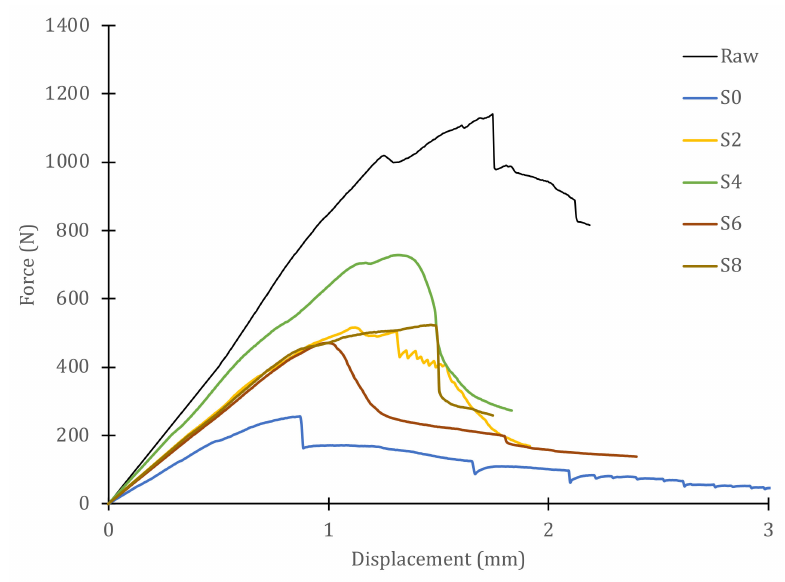
Figure 8. Iosipescu shear test curves for dry samples after 900,000 cyclic impacts.